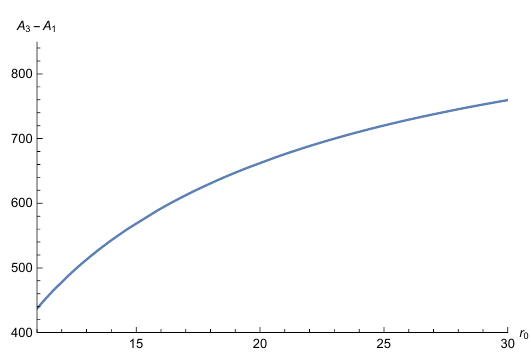
Figure 10. Here we have plotted the difference between A 3 , given in eq. (A.34), and A 1 , given in eq. (A.29), as a function of the turning point r 0 , for r UV = 10 4 , n = 3 , r h = 10